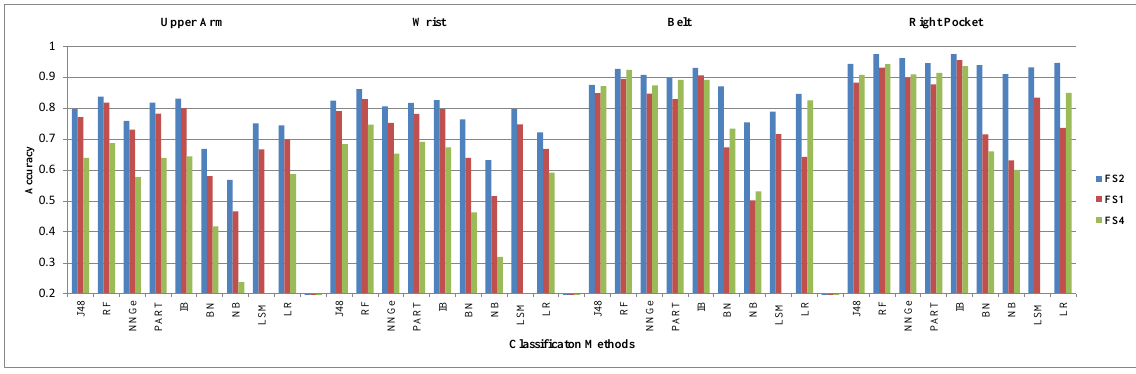
Figure A.6. Gyroscope TPR for the walking upstairs activity for all four positions and three feature sets.